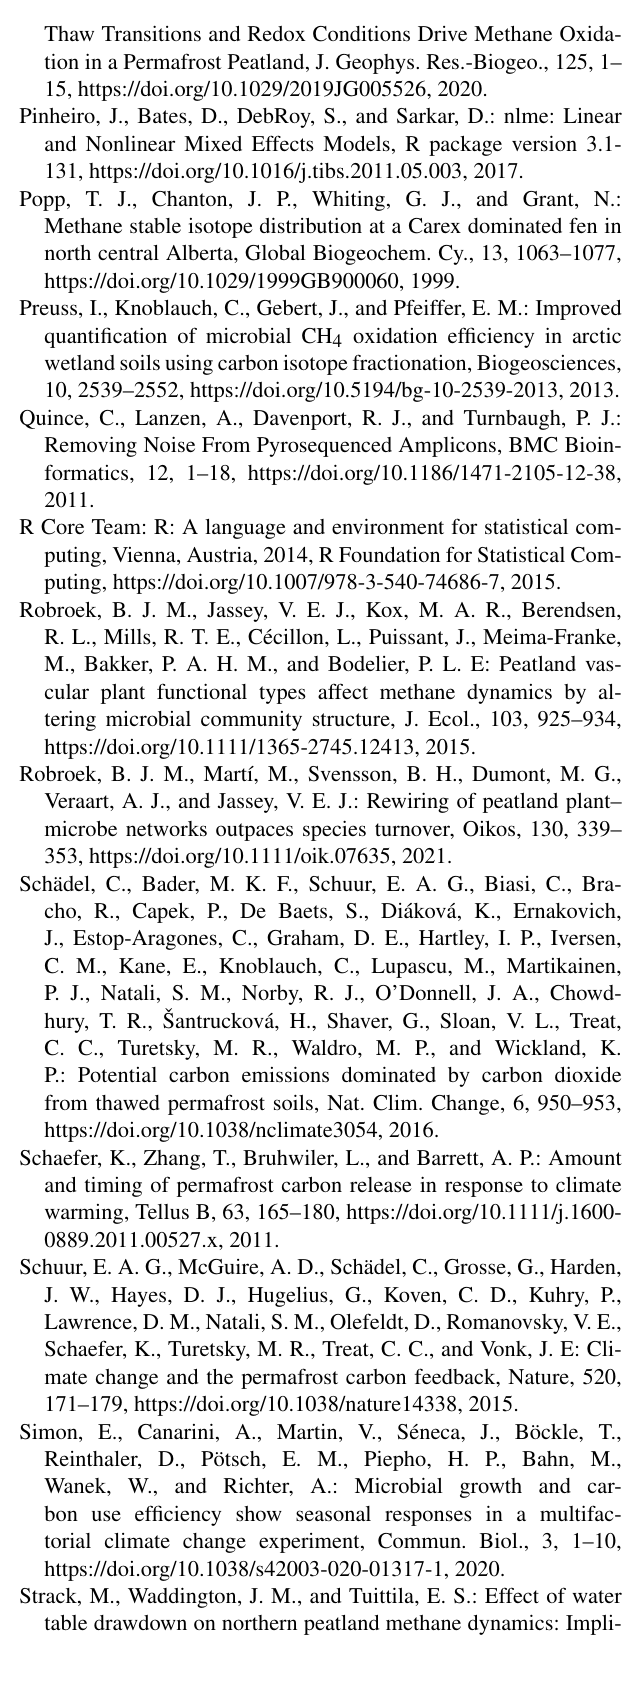
table drawdown on northern peatland methane dynamics: